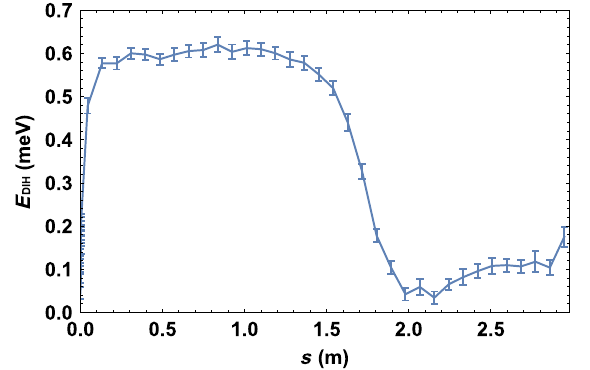
FIG. 11. Energy from disorder-induced heating as calculated from g ð r Þ in the NCRF beam line with 0 MTE and a smaller initial density of 10 17 m − 3 . The density was reduced by increas- ing the initial radial size of the electron beam at the cathode.